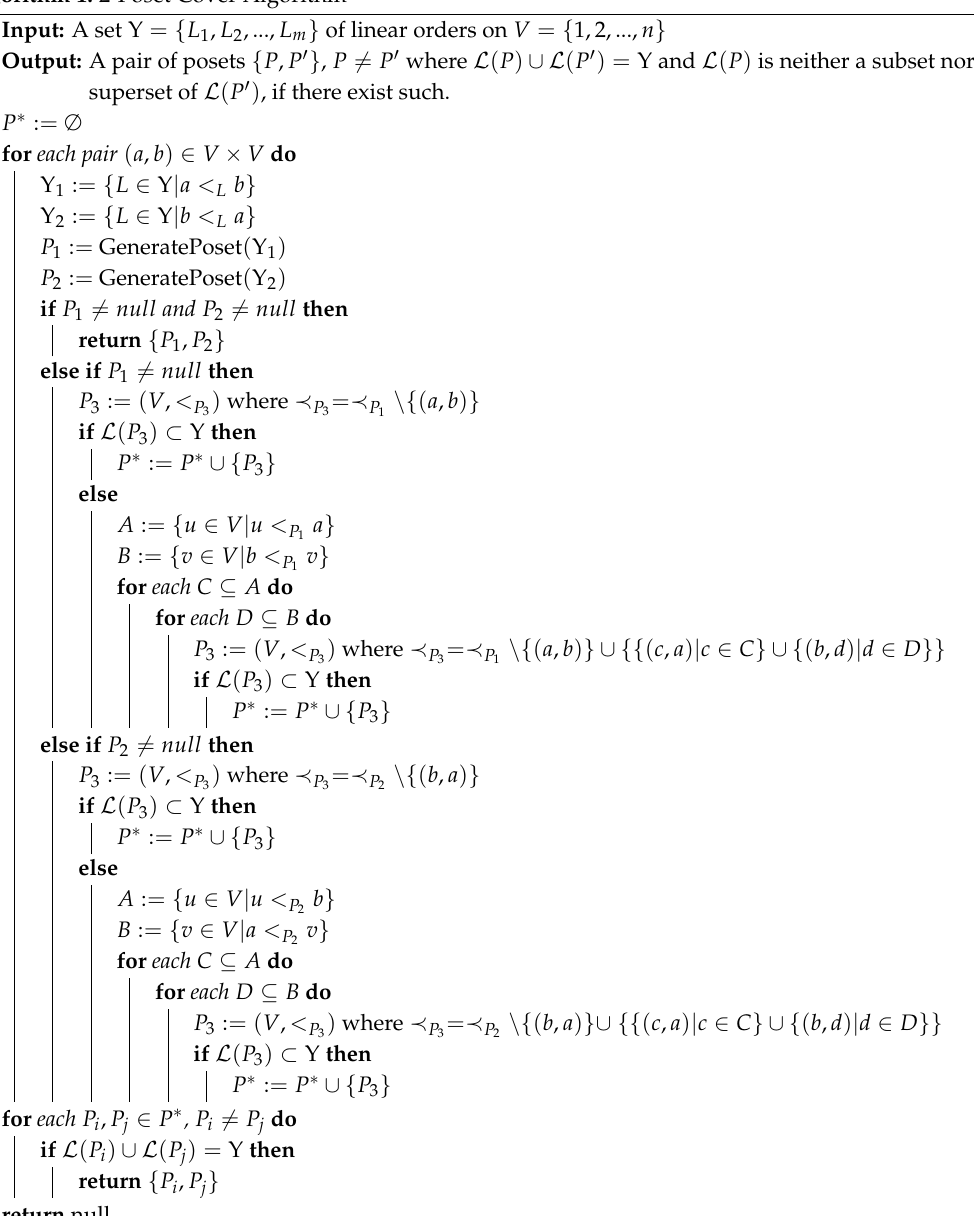
Algorithm 1: 2-Poset Cover